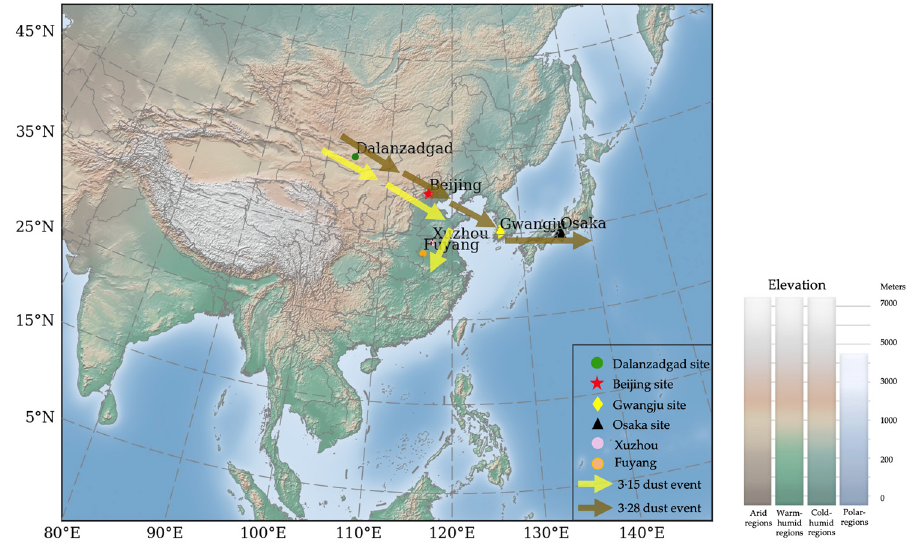
Figure 1. Illustration of the two dust events in March 2021. The yellow arrows represent the pathway of the 3·15 dust event, and the brown arrows represent the pathway of the 3·28 dust event . Aerosol particle volume size distribution 𝑑𝑉(cid:4666)𝑟(cid:4667) 𝑑𝑙𝑛𝑟⁄ ( μm (cid:2871) μm (cid:2870) ⁄ ) is an inversion